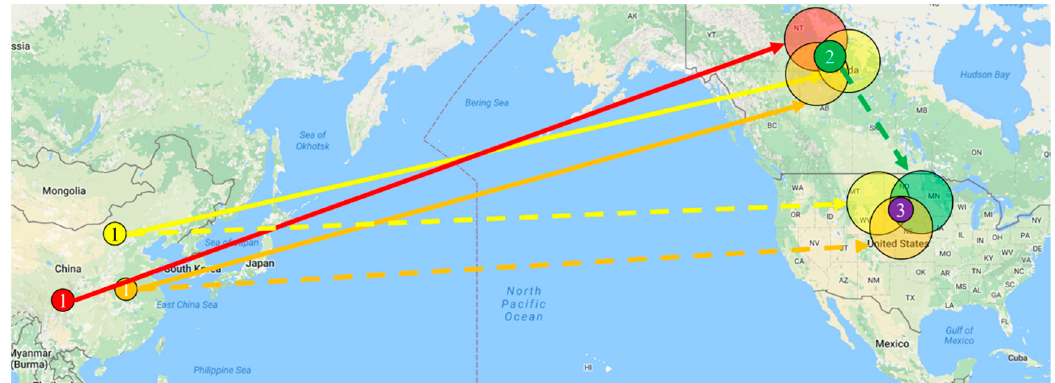
Figure 1. Schematic diagram of triangulation.